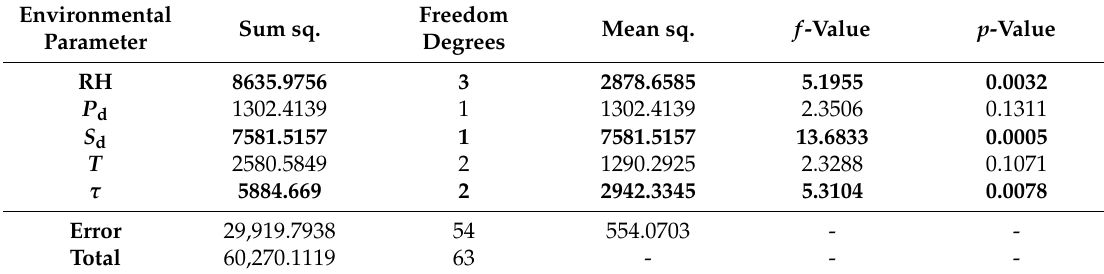
Table 4. Statistical analysis of results for zinc.